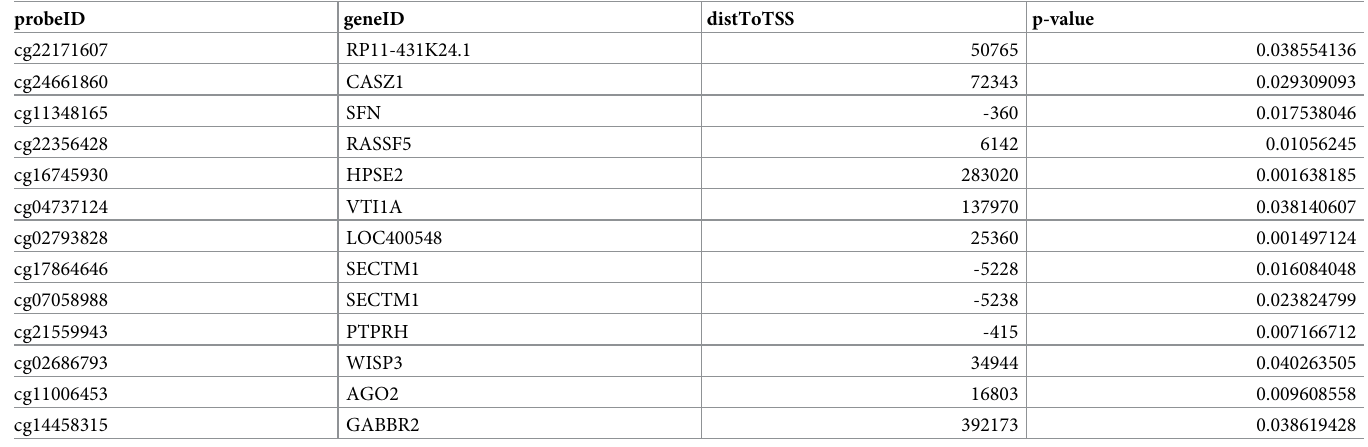
Table 1. Differentially methylated MAX binding sites between NFPA vs.